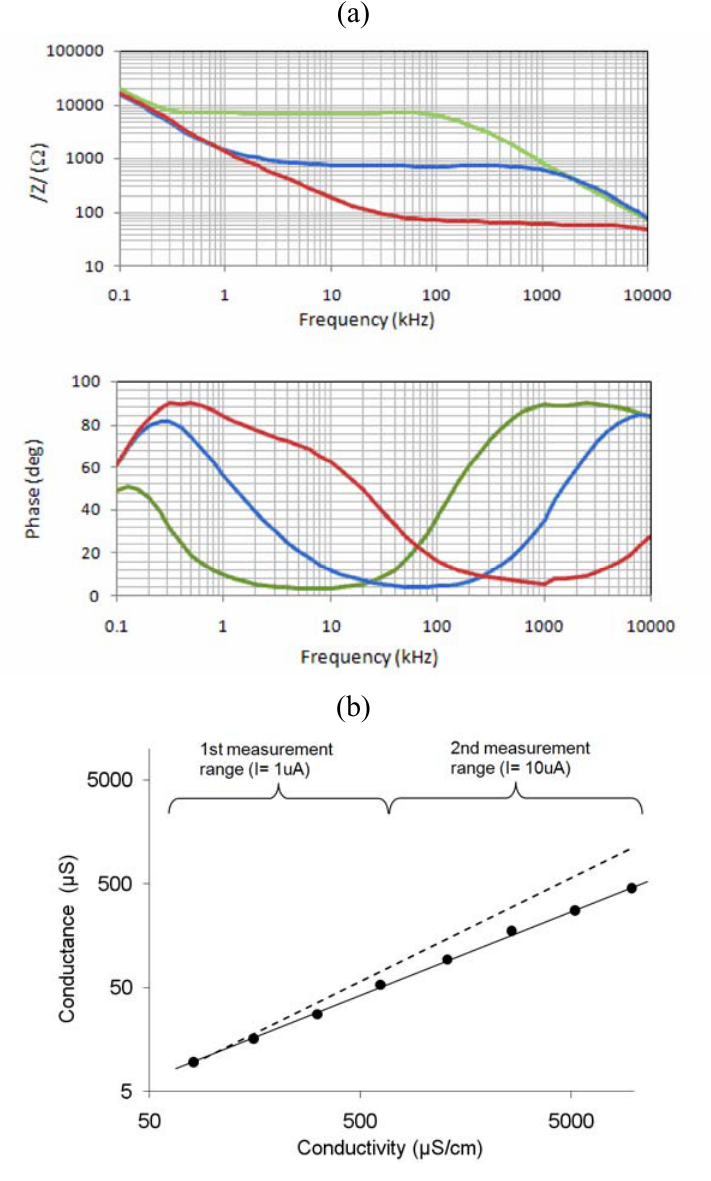
Figure 4. Characterization results of the 4-electrode array: (a) Impedance spectra for 0.97 mS/cm (green), 9.10 mS/cm (blue) and 96.7 mS/cm (red) as measured with